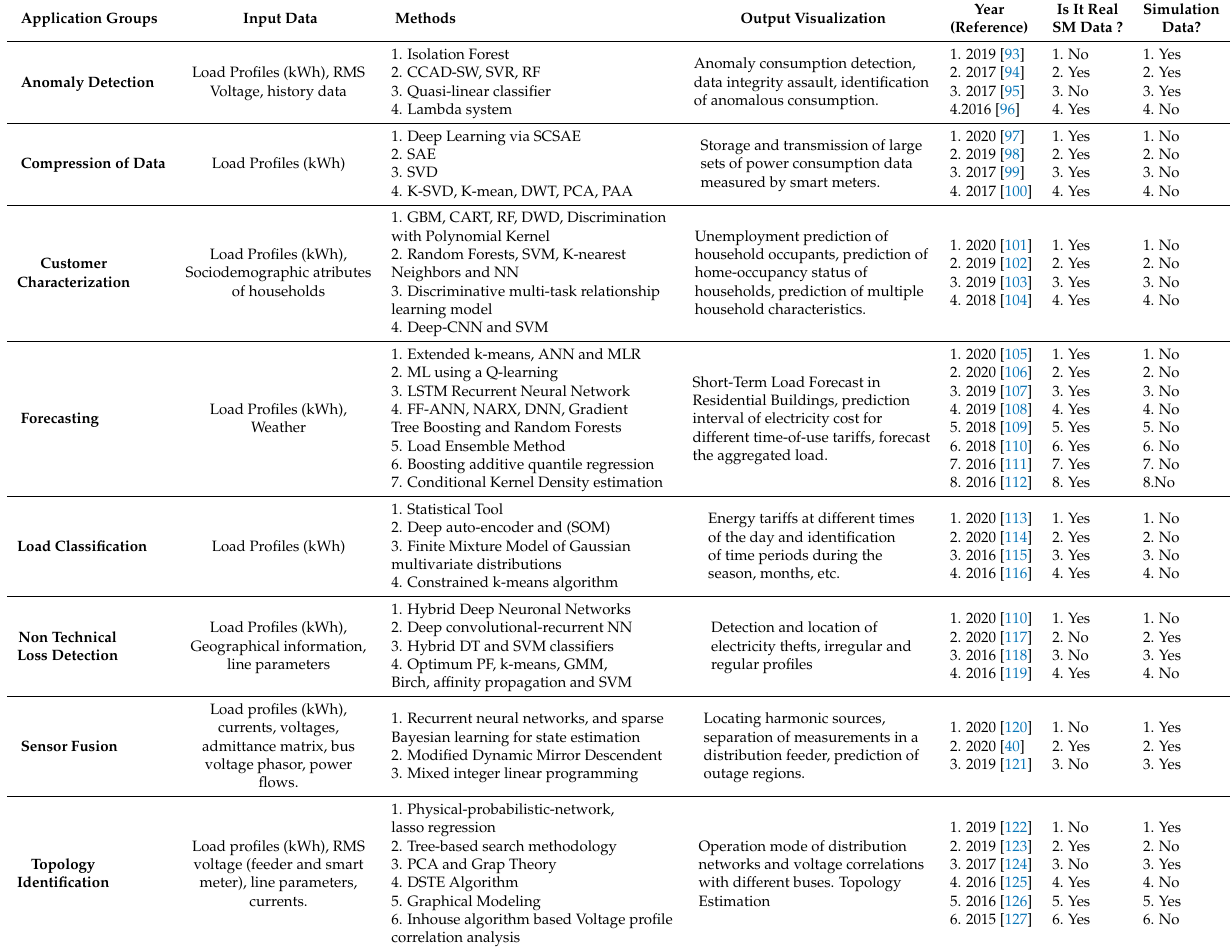
Table 4. Recent application groups of Smart Meter